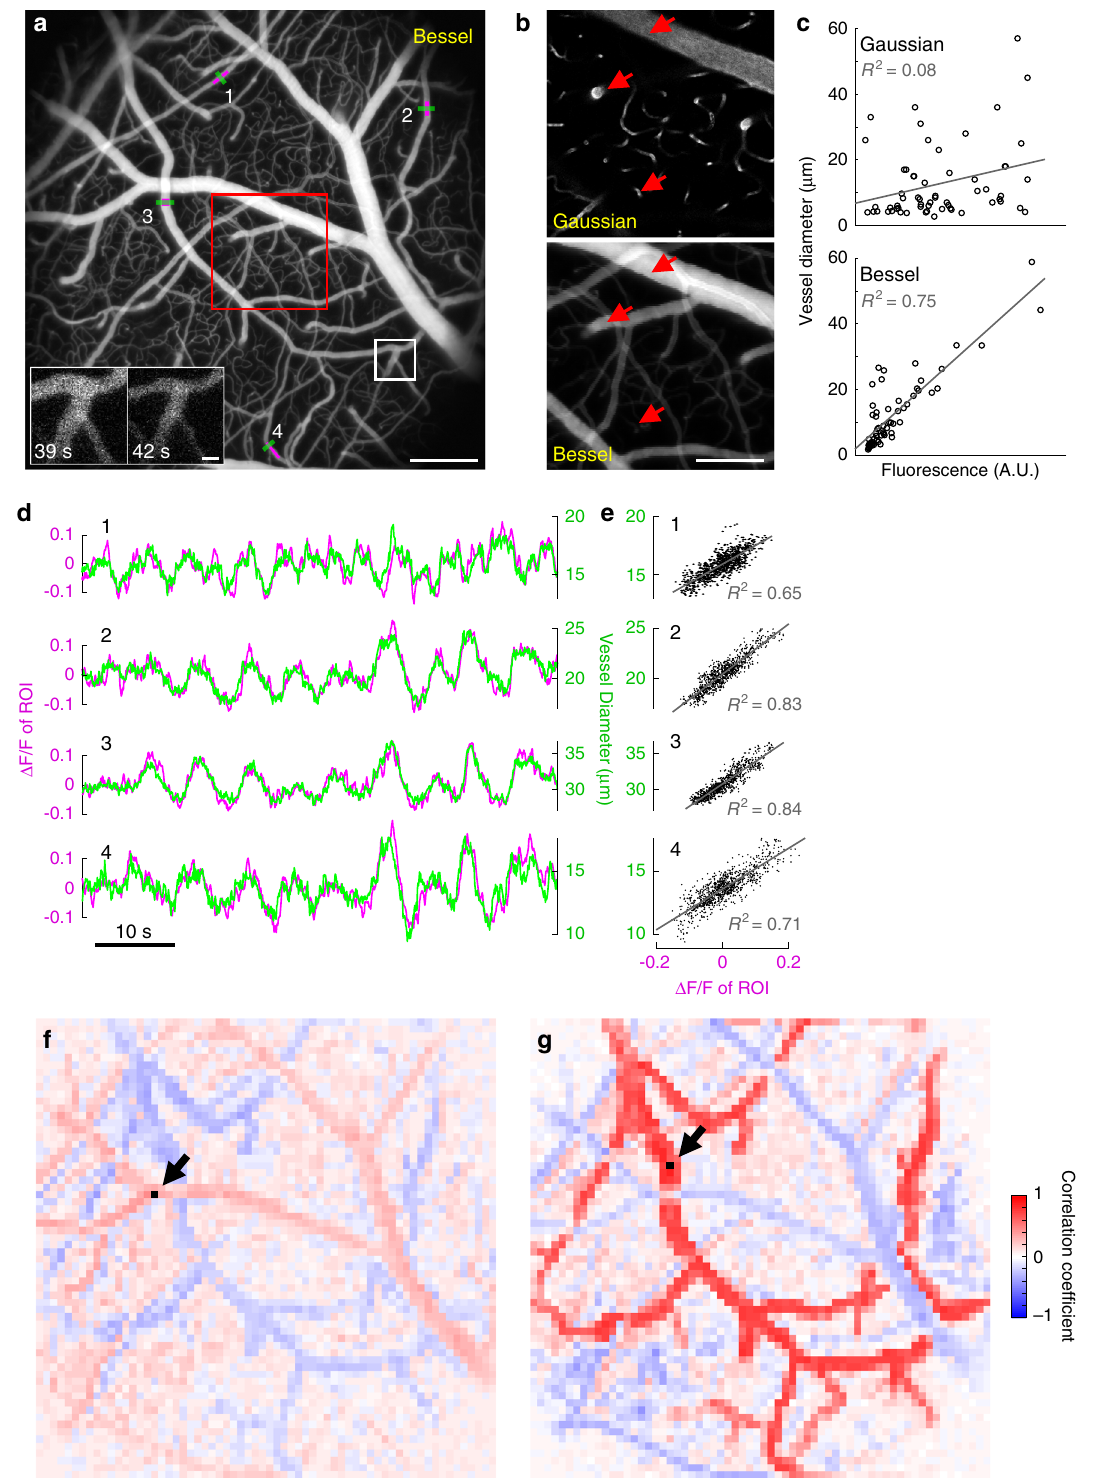
found that temporal variations in vessel size over 1 min of recording (e.g., green traces in Fig. 3d, measured along green lines for four example vessel segments labeled 1 – 4 in Fig. 3a) were positively correlated with the brightness changes of its lumen (e.g., magenta traces in Fig. 3d, averaged brightness within the magenta regions of interest (ROIs) in Fig. 3a; quanti fi ed as Δ F/F, with F being the median value of the time trace) (Fig.